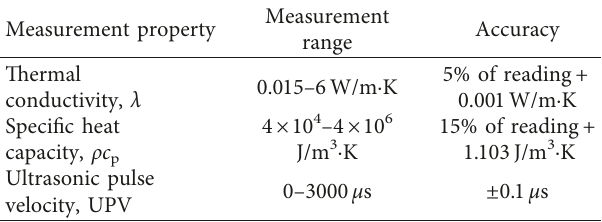
Figure 2: The measurement devices of ultrasonic pulse velocity and the thermal property. Table 1: Technical specifications of devices for measuring parameters.